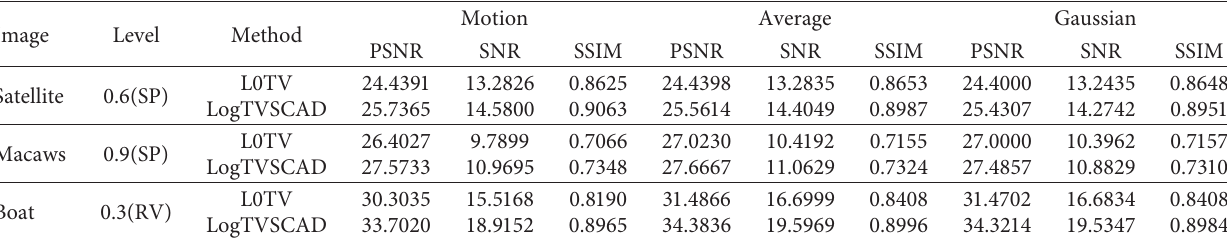
Figure 21: The recovery results (boat 1024 × 1024) by Gaussian blur with 30% RV noise. (a) Gaussian blur (lev � 0.3). (b) L0TV, Table 2: Performance comparison of L0TV and LogTVSACD